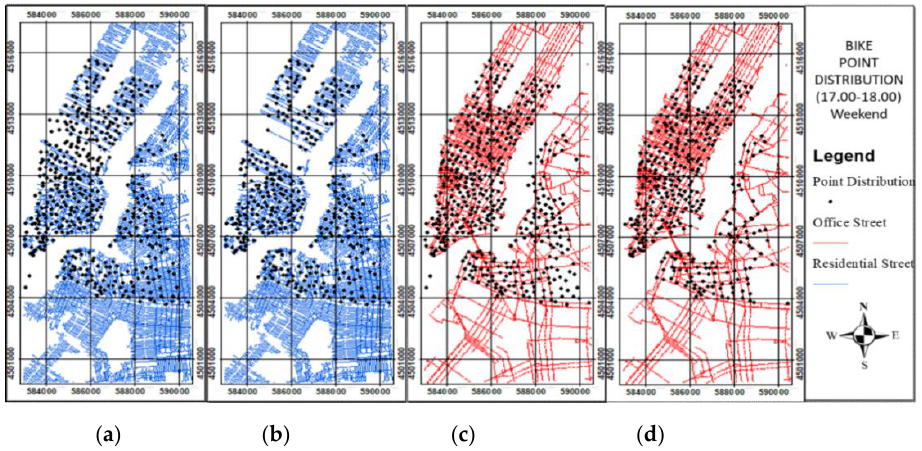
Figure 13. Bike point distribution at the weekend peak time (17:00 – 18:00): ( a ) origin before data cleaning; ( b ) origin after data cleaning ( c ) destination before data cleaning; ( d ) destination after data cleaning.